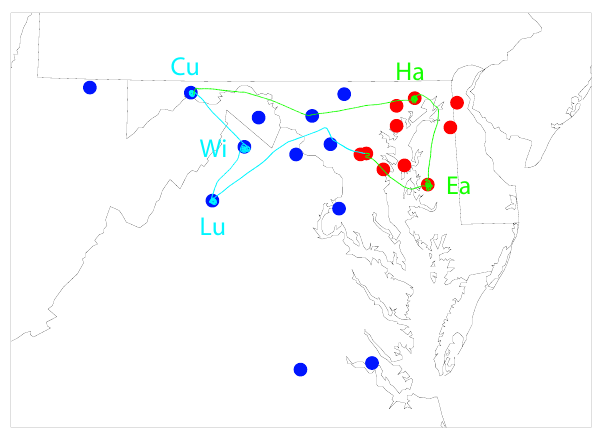
Fig. 1. Locations of the selected RAMMPP research spirals in the Baltimore/Washington airshed. Cyan and Green lines show the route of morning and afternoon flights, respectively, during a typ- ical westerly transport flight pattern. Blue and Red dots show the locations of morning and afternoon spirals, respectively. Five air- ports (the spiral locations) extensively covered by this flight pattern are, from the lower left, clockwise: Luray, VA (38.67 ◦ N, 78.50 ◦ W, “Lu”, 65 spirals), Winchester, VA (39.14 ◦ N, 78.14 ◦ W, “Wi”,